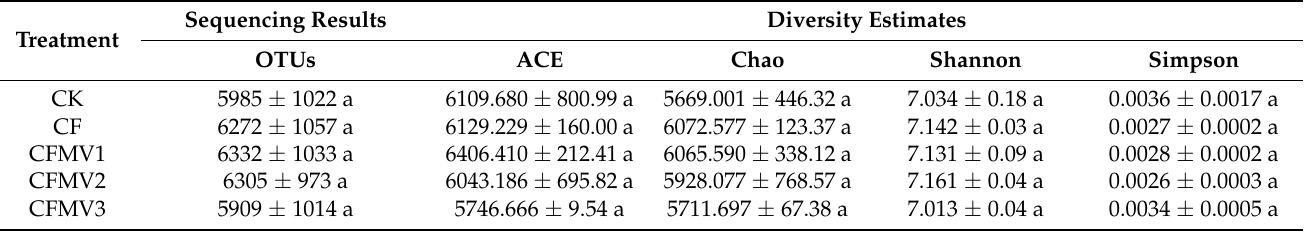
(Table 2), which indicates that the moderate use of CMV increased soil bacterial abundance and diversity. Table 2. Richness and diversity indexes of bacteria in the paddy soil treated.